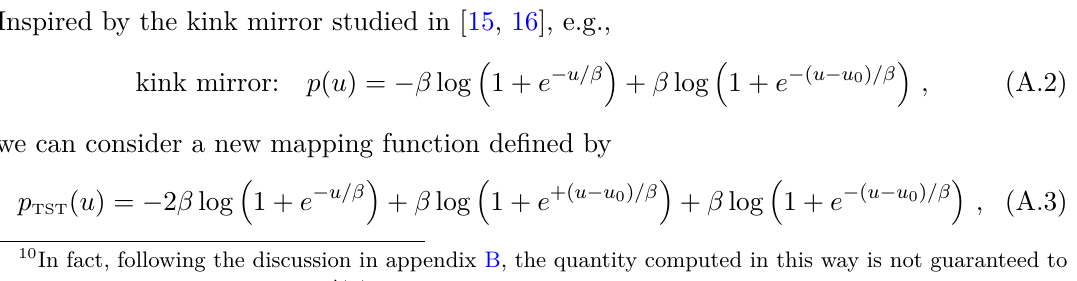
. The TST mirror is obtained when u 0